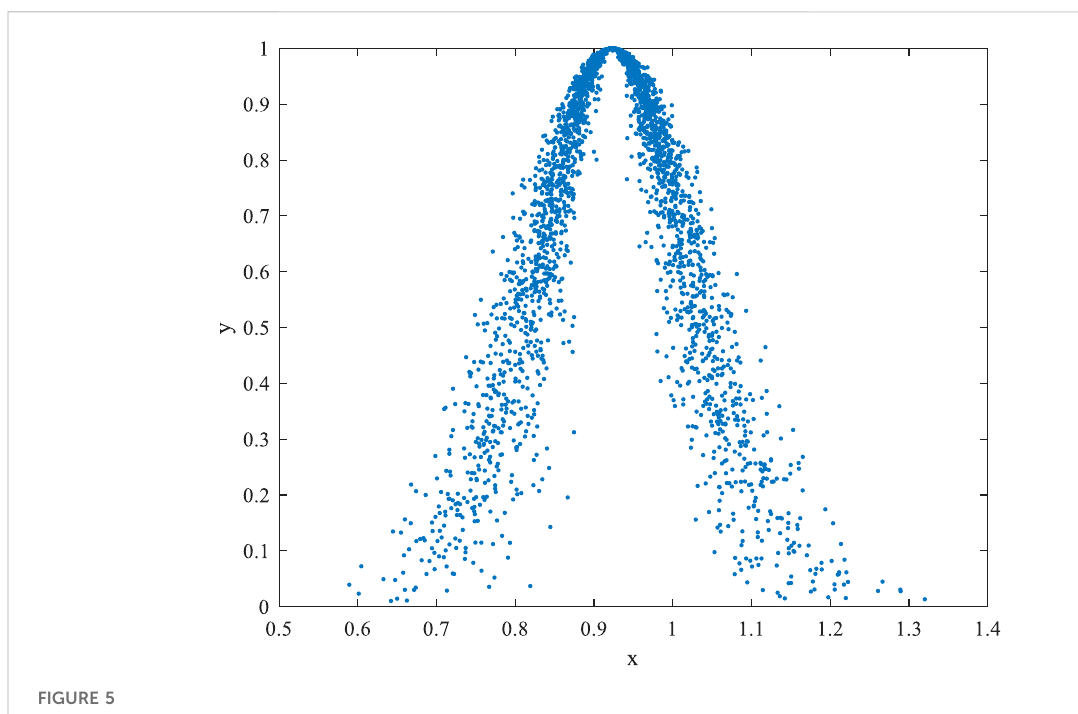
FIGURE 5 Distribution of typical cloud